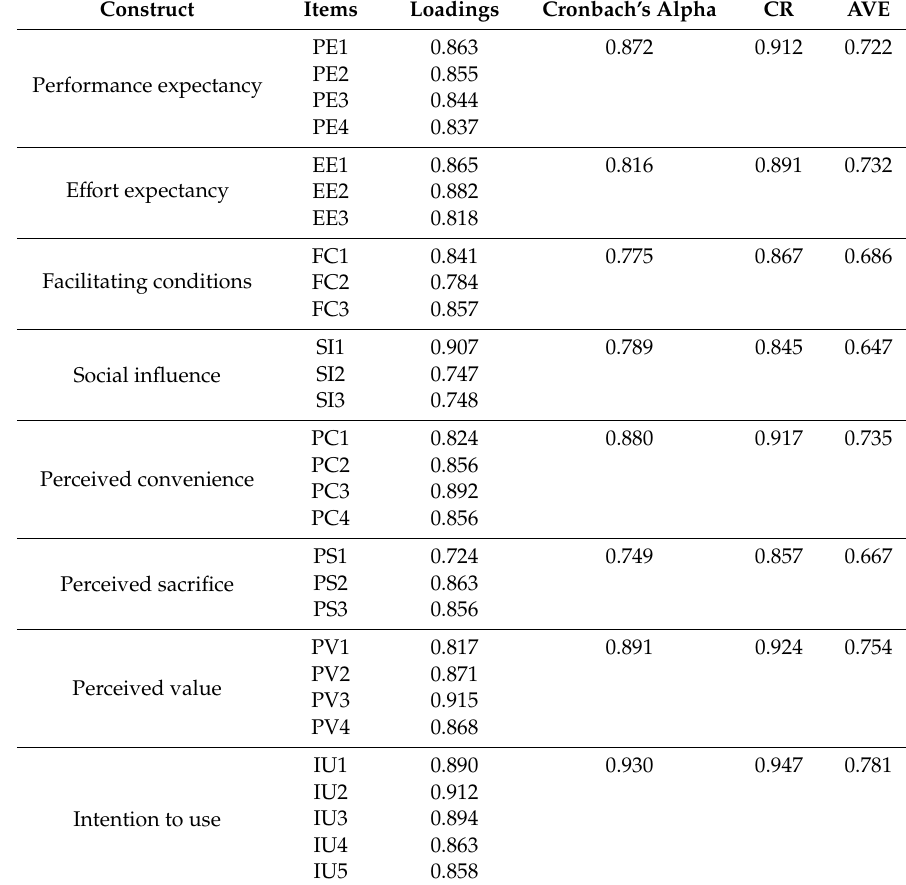
Table 2. Results of all item loadings, reliability and convergent validity testing.